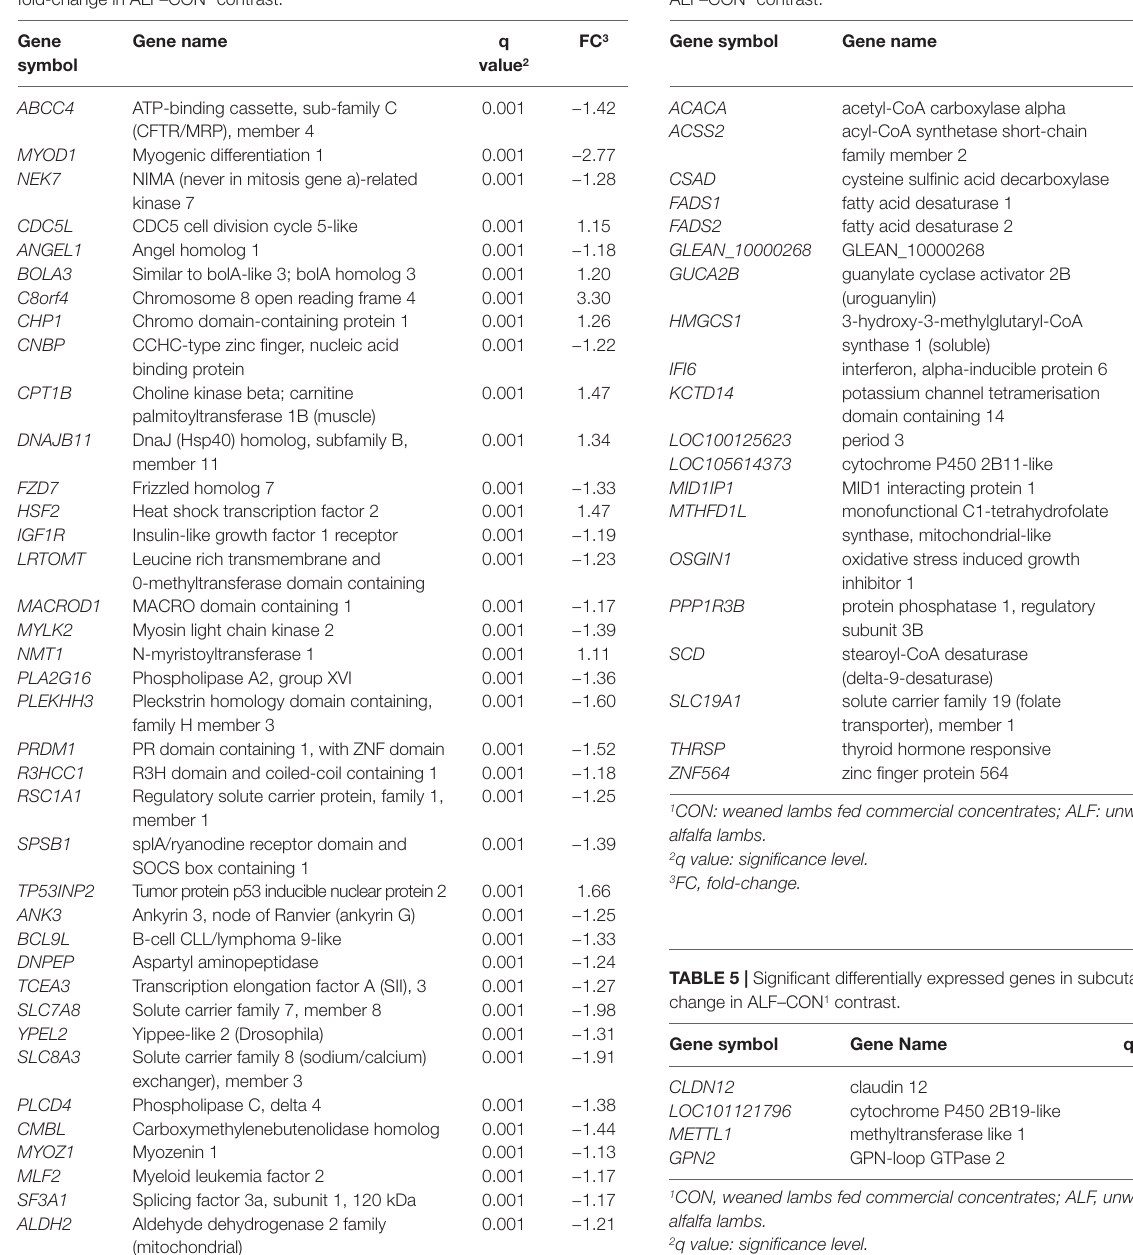
TABLE 4 | Top 20 differentially expressed genes in the liver and fold-change in ALF–CON 1